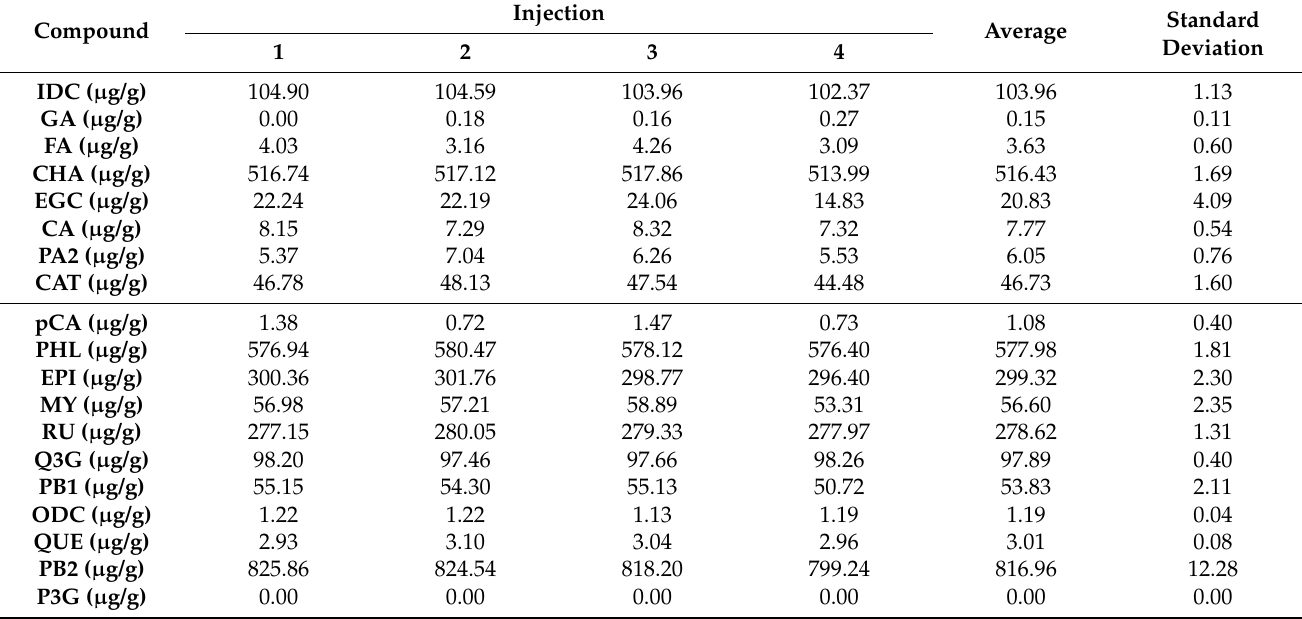
Table A5. Measurement repeatability.